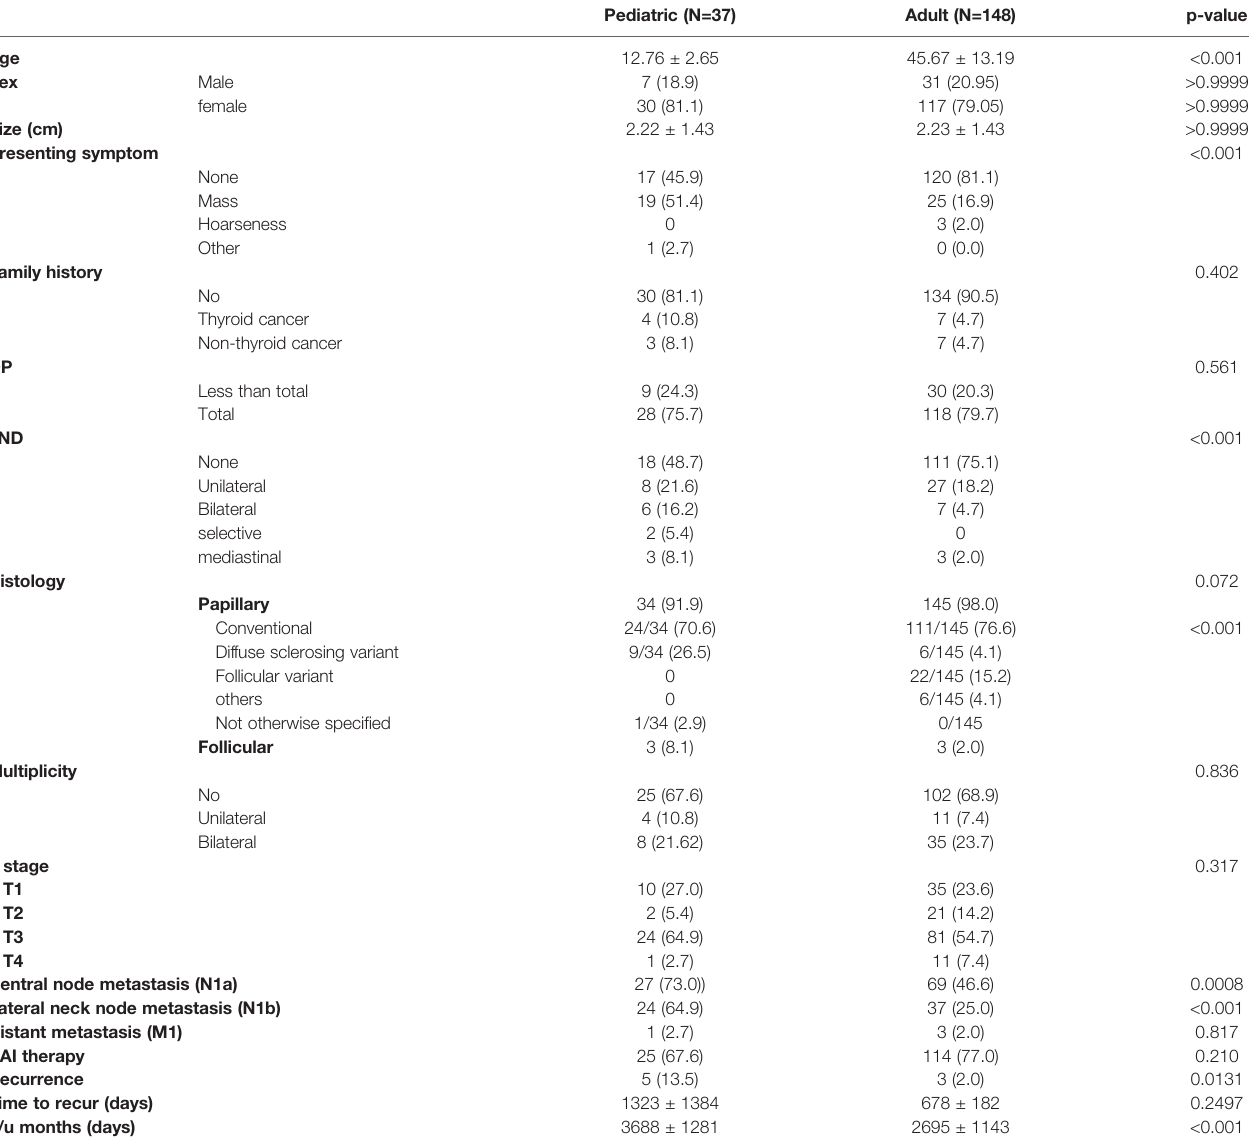
TABLE 2 | 1:4 Propensity score-matched GEE